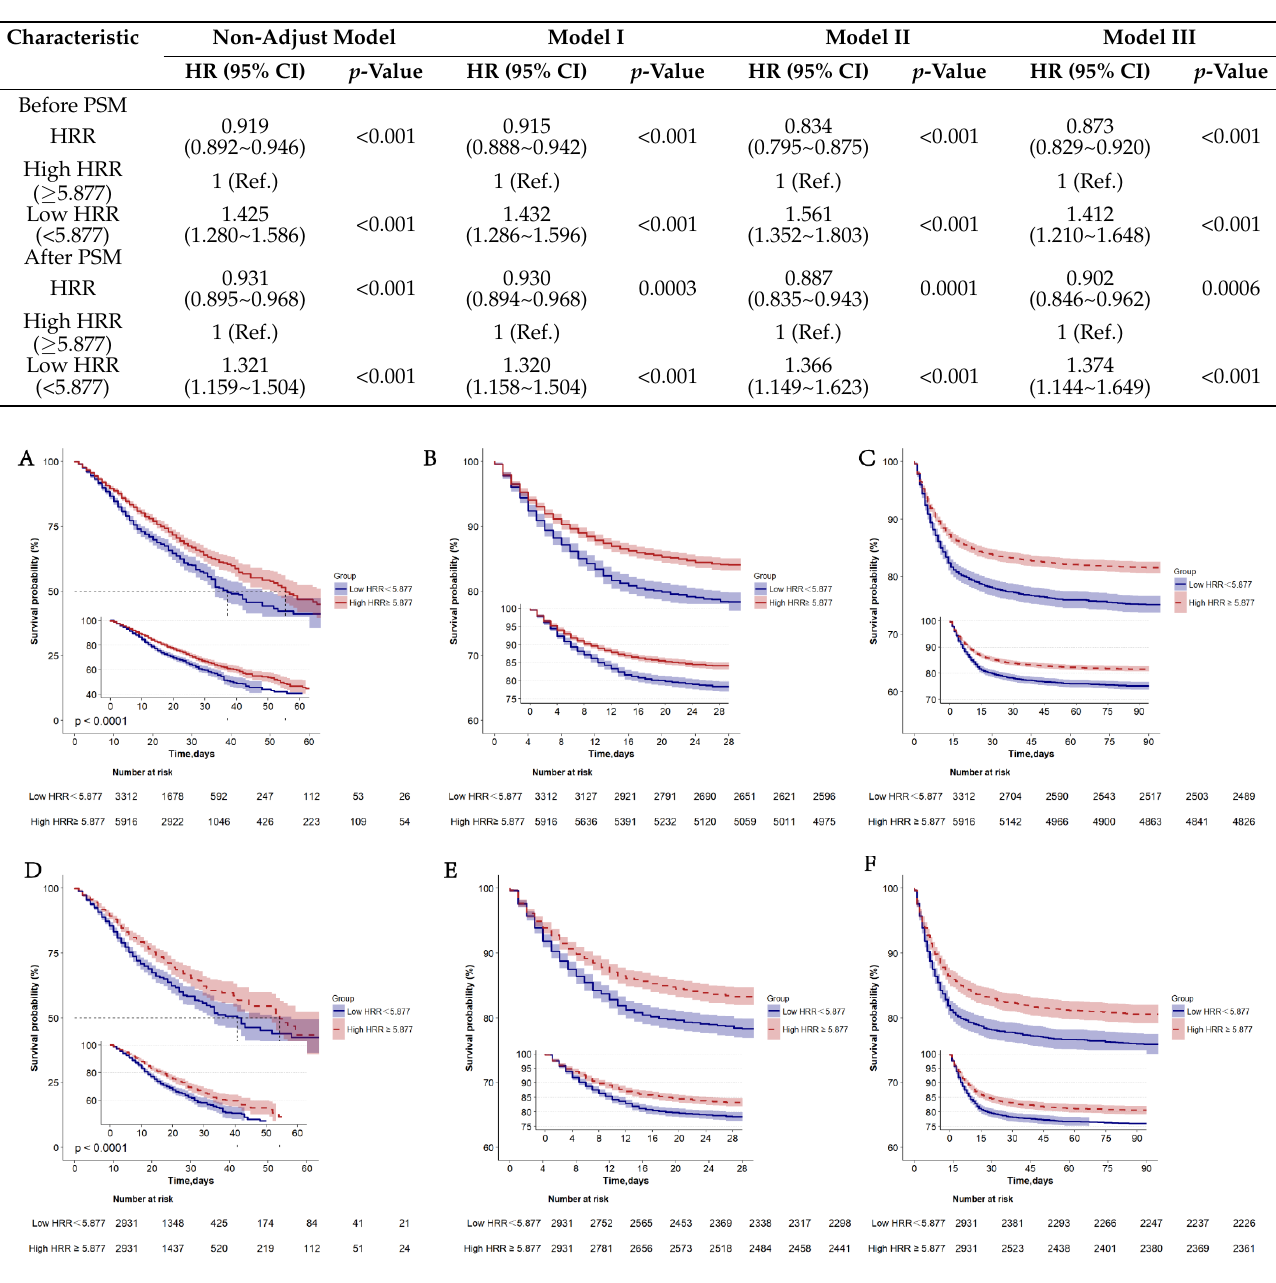
Figure 2. Kaplan–Meier survival curves of in ‐ hospital mortality, 28 ‐ day mortality, and 90 ‐ day mor ‐